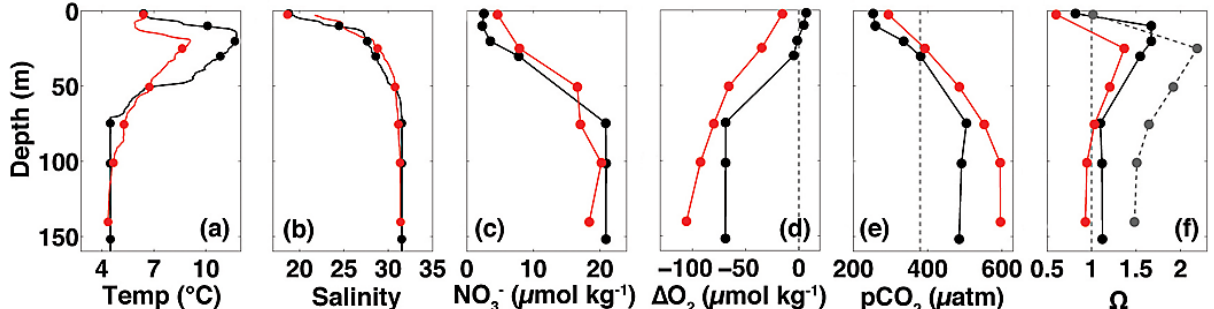
Fig. 6. Depth profiles from Icy Bay (Fig. 1) collected during September in 2011 (black) and 2012 (red) of temperature ( a ; ◦ C), salinity (b) , NO − ( c ; µmolkg − 1 ), 1 O 2 ( d ; µmolkg − 1 ), p CO 2 ( e ; µatm), and (cid:127) (f) . Temperature and salinity traces are from CTD downcasts, and 3 dots are the measurements made at the depth Niskin bottles were fired during upcasts. The gray dashed line in panel (d) denotes 1 O 2 in equilibrium with the atmosphere. The gray dashed line in (e) is the atmospheric p CO 2 for September 2012 in PWS from Evans and Mathis (2013). The gray vertical line in (f) is the (cid:127) = 1 level below which CaCO 3 dissolution will occur. (f) Shows (cid:127) arag for September 2011 (black), and both (cid:127) arag (red) and (cid:127) calc (gray) from September 2012; nearly corrosive surface levels of (cid:127) calc (1.02) were seen here for the first time in the GOA.